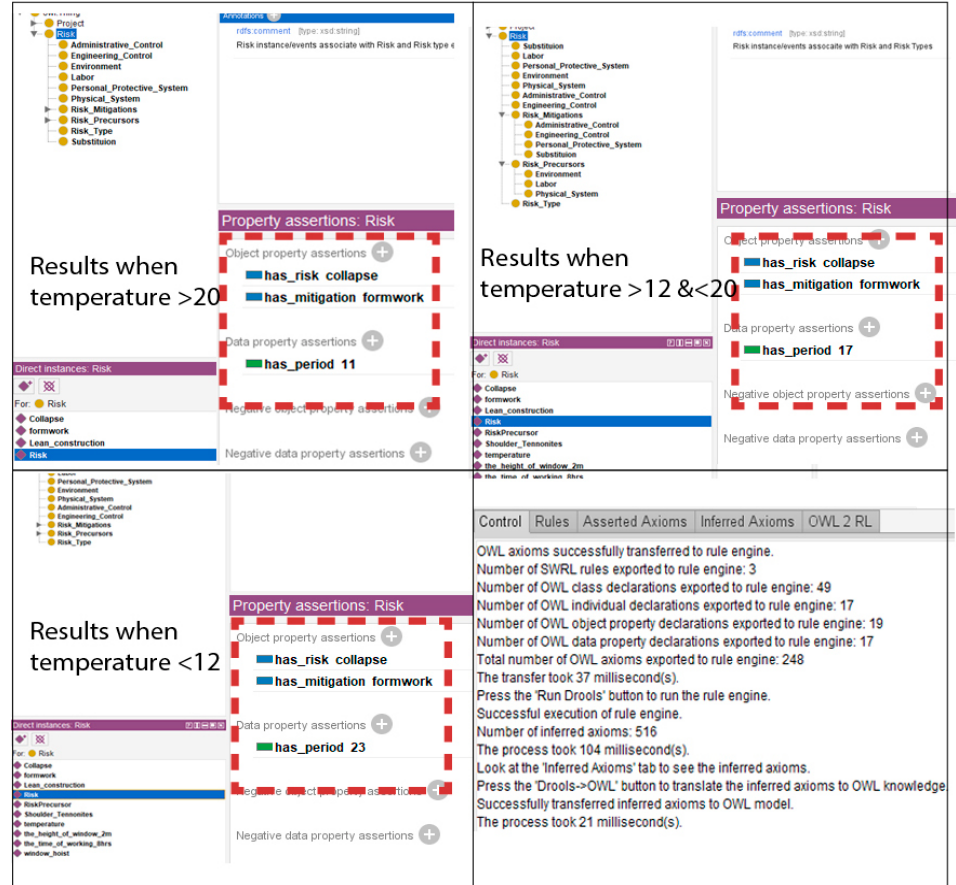
Figure 13. Protégé screenshot of execution and results of SWRL rules for decision making. Figure 13. Prot é g é screenshot of execution and results of SWRL rules for decision